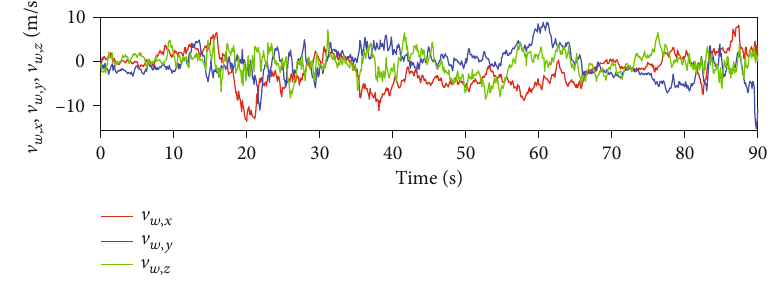
Þ by the FXESO observer: fl ight scenario 1. , ̂ v , ̂ v x y z